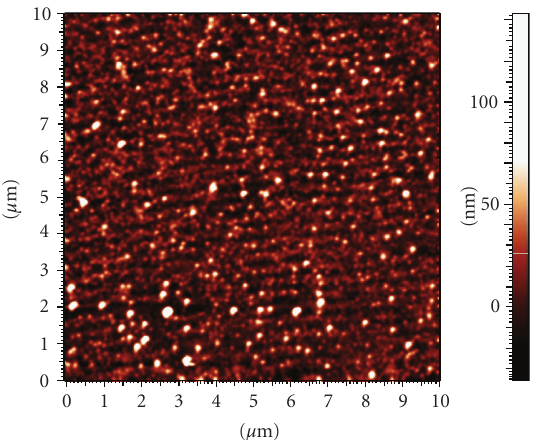
Figure 8: AFM-images of the photosensitive layer based on the optically attained (3 minutes) nanostructured AgCl-Ag.